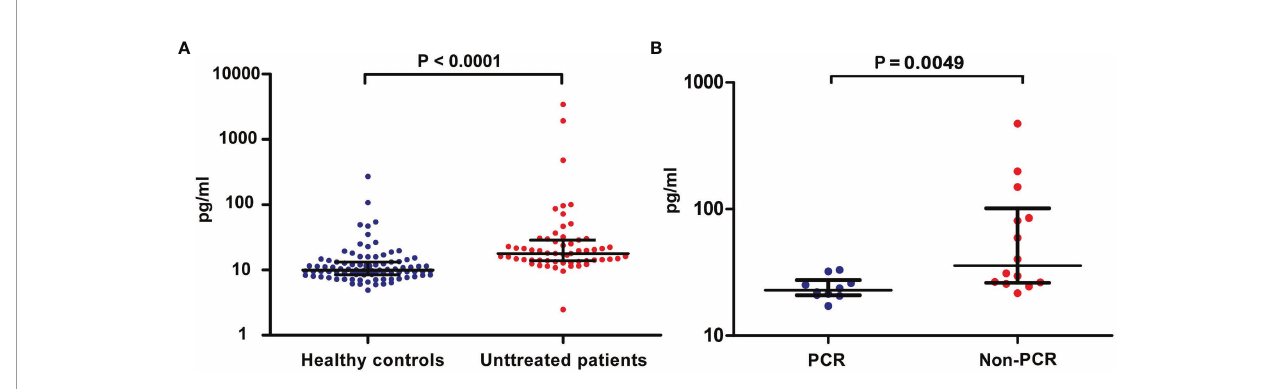
FIGURE 1 | Levels of blood sCD137 in patients with lung cancer. (A) sCD137 levels in blood samples from 91 healthy controls and 59 untreated patients. (B) Baseline blood sCD137 levels in neoadjuvant immunochemotherapy-treated patients with a pathological complete response (PCR) and neoadjuvant immunochemotherapy-treated patients without pathological complete response (Non-PCR). Differences are indicated as P values. The error bars represent the